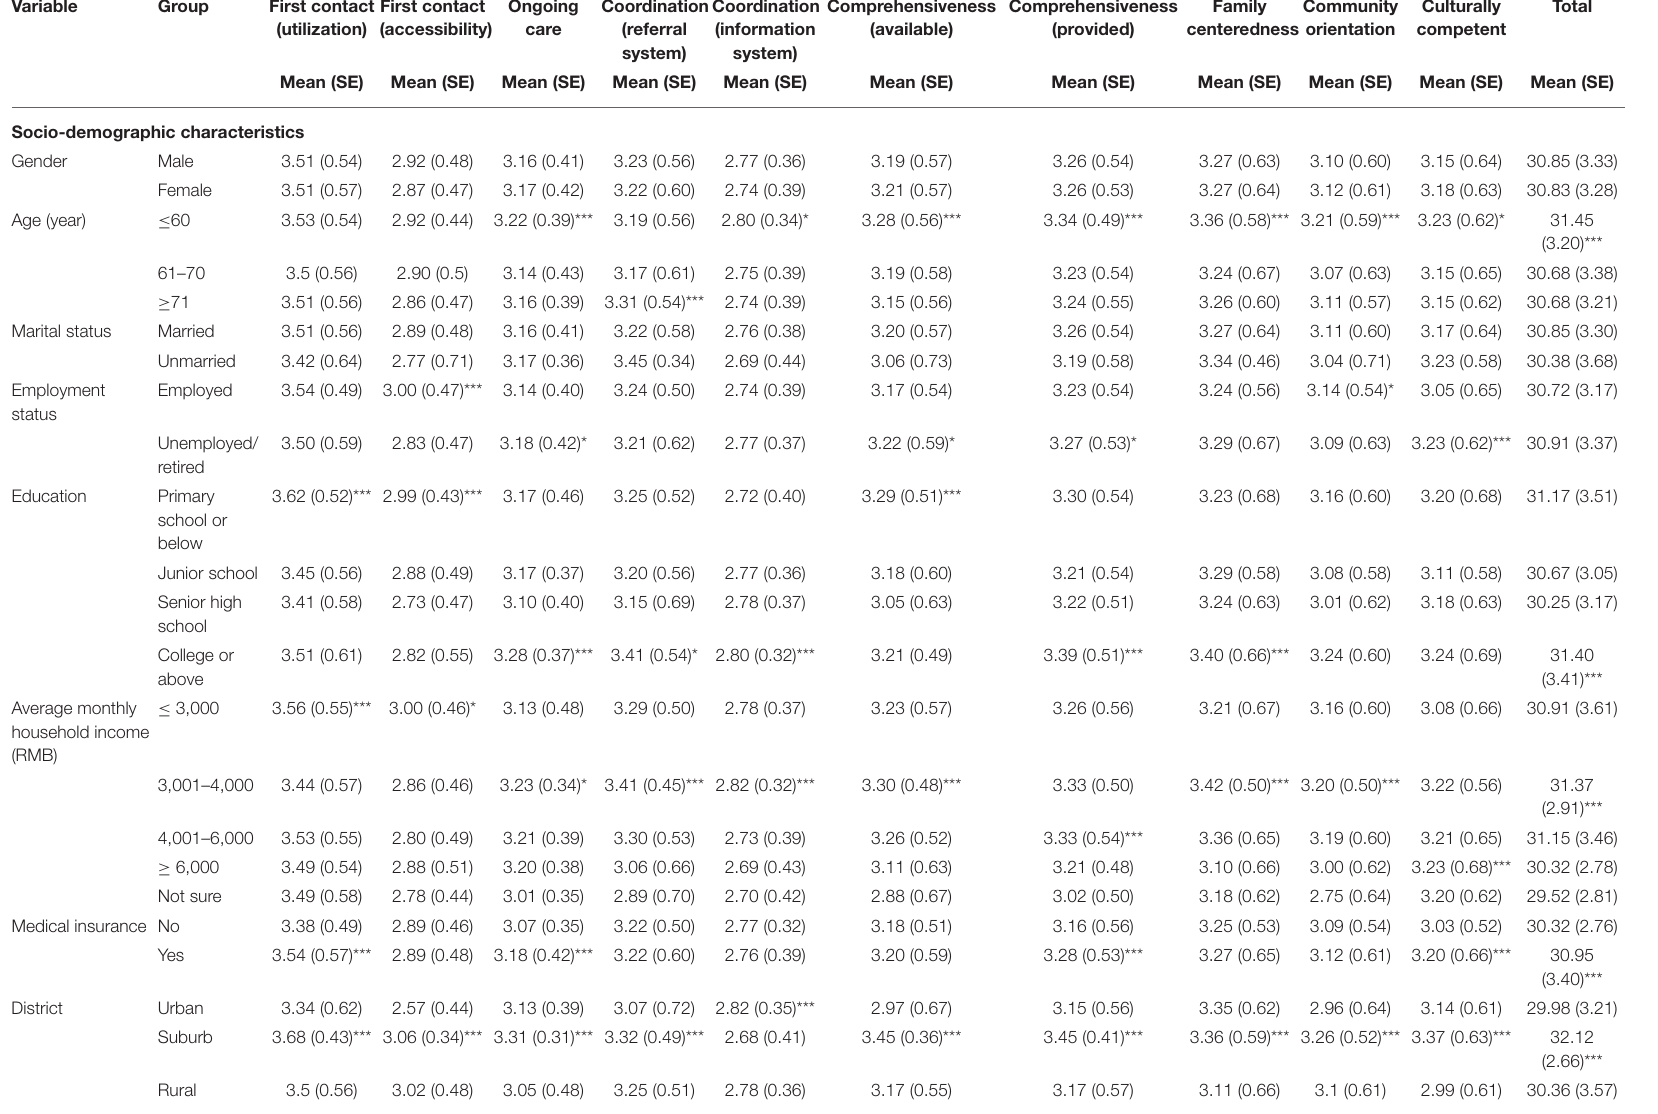
TABLE 2 | Comparison of PCAT scores by participants’ characteristics.